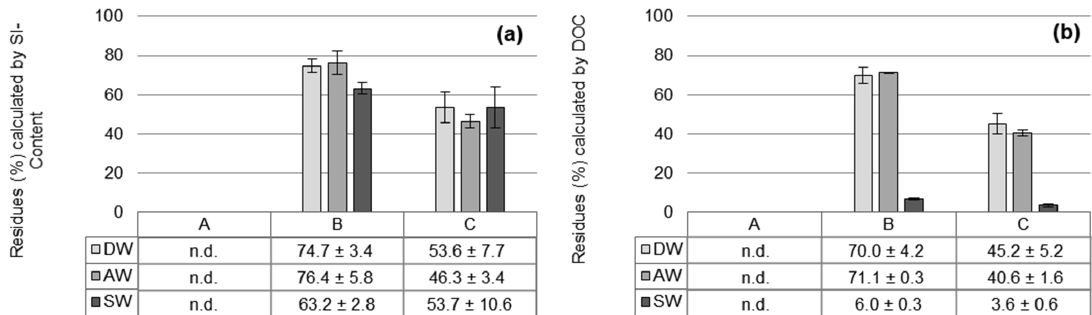
Figure 7. Percentage of organosilane residues in the water calculated from the Si content ( a ) and DOC content ( b ) after adding 100 mg PE/PP (50:50) in 1 L water, subsequently adding 100 µL organosilane and stirring for 20 min. (DW = demineralized Water; SW = salt water; WW = biological treated wastewater; A = PE-X; B = n-butyltrichlorosilane; C = isooctyltrichlorosilane). For DOC 100% correspond to A = 58.7 mg / L, B = 29.1 mg / L and C = 41.8 mg / L. For Si content 100% corresponds to A = 17.2 mg / L, B = 17 mg / L and C = 12.1 mg / L.